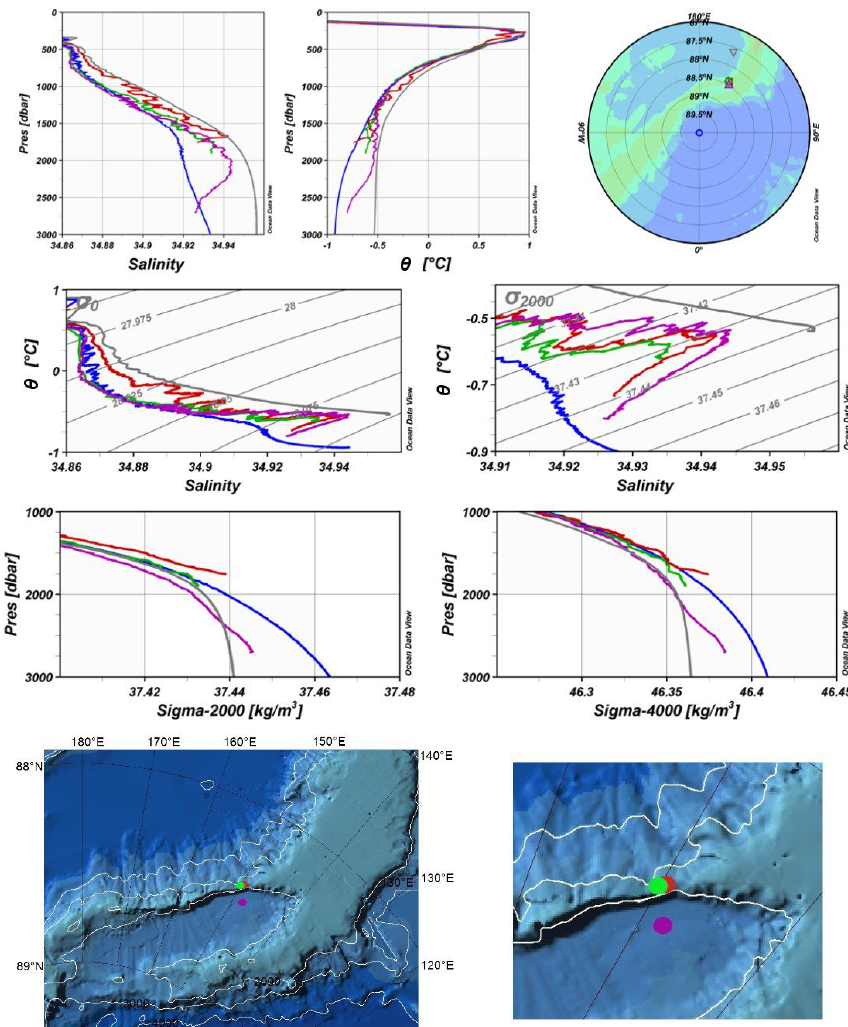
Fig. 18. Potential temperature and salinity profiles and θS curves from stations in the Makarov Basin, the Amundsen Basin and the intra- basin in the Lomonosov Ridge (lower map left). The magenta station from the interior of the intra-basin and the green station at the sill (lower map right), as well as the stations in the Amundsen and Makarov basins, were taken in 2005 by Oden. The orange station at the sill was taken by Oden in 2001. The 2001 station indicates that water deriving from the Amundsen Basin deep water was present in the deepest part, located above the sill depth to the Makarov Basin. If this water crossed the sill, it could sink down to 2500m in the Makarov